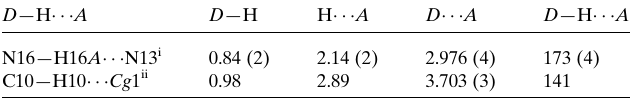
Table 2 Experimental details. Crystal data Chemical